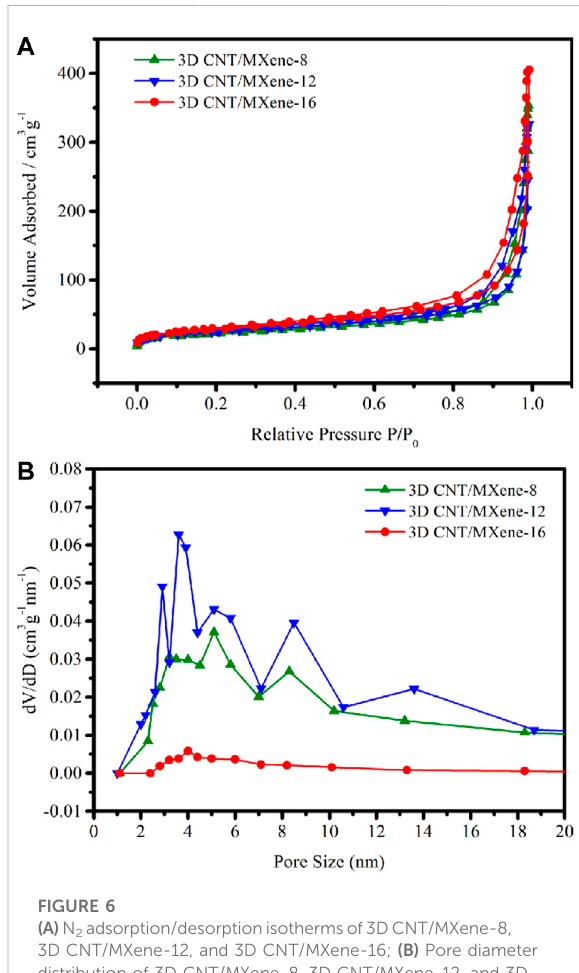
FIGURE 6 (A) N 2 adsorption/desorptionisothermsof3DCNT/MXene-8, 3D CNT/MXene-12, and 3D CNT/MXene-16; (B) Pore diameter distribution of 3D CNT/MXene-8, 3D CNT/MXene-12, and 3D